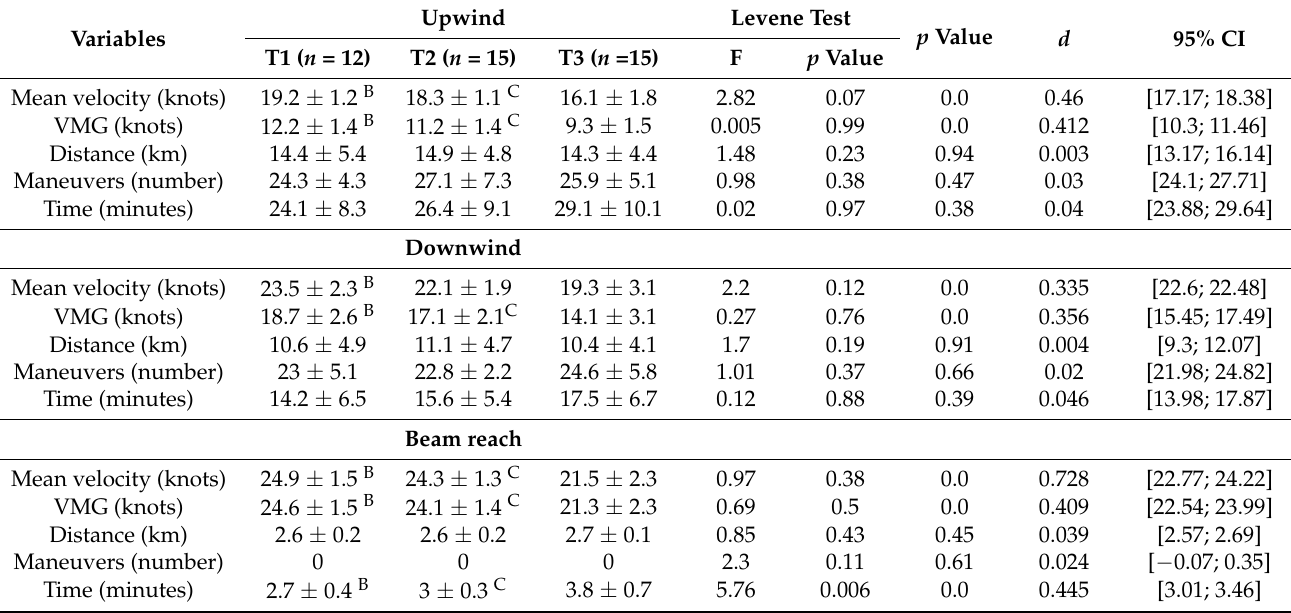
Table 2. Data of mean velocity (M), VMG, distance, maneuvers, and time in upwind, downwind, and beam reach in groups of sailors with different performance levels (T1, T2, and T3).